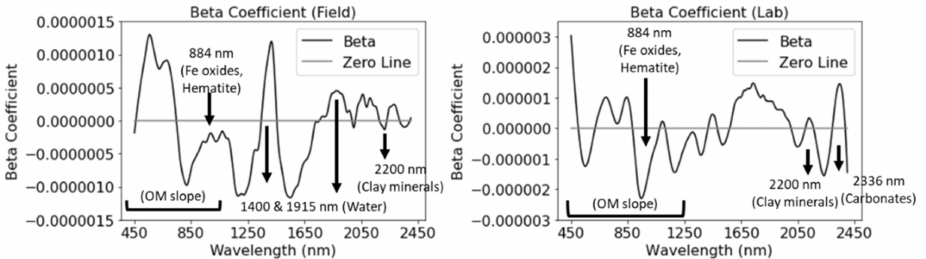
Figure 11. Beta coefficients of the PLSR models for the prediction of WIR using the samples of the clayey group with the ASD spectral resolution.